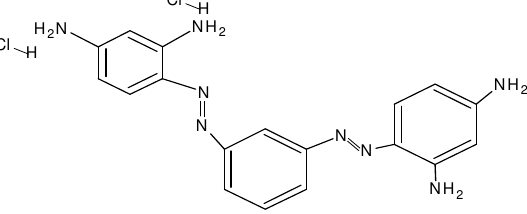
Figure1. The structural formula of Bismarck brown